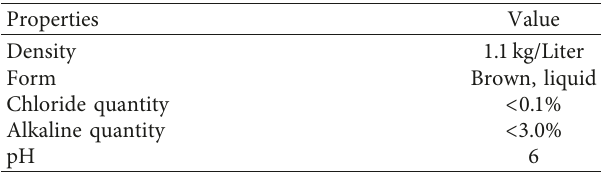
Table 2: Properties of superplasticizer.